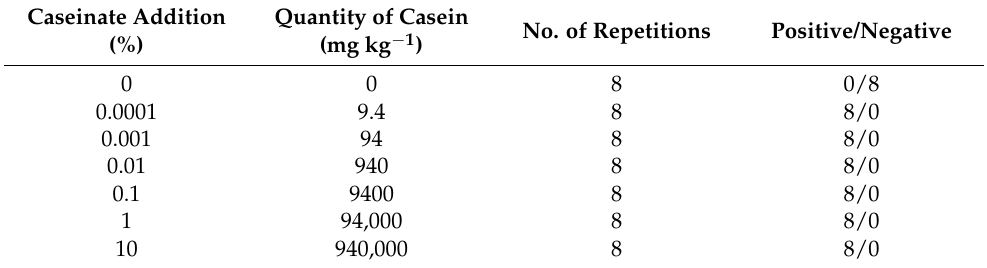
Table 3. Limit of detection.